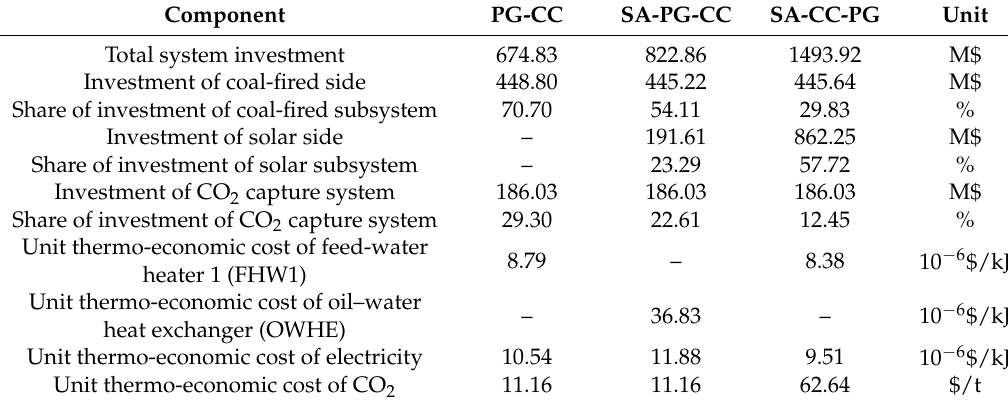
Table 9. Main results of the thermo-economic analysis for coal-fired power-generation system with MEA-based CO 2 capture (PG-CC), solar-aided coal-fired power generation with CO 2 capture (SA-PG-CC) and solar-aided CO 2 capture coal-fired power generation (SA-CC-PG).